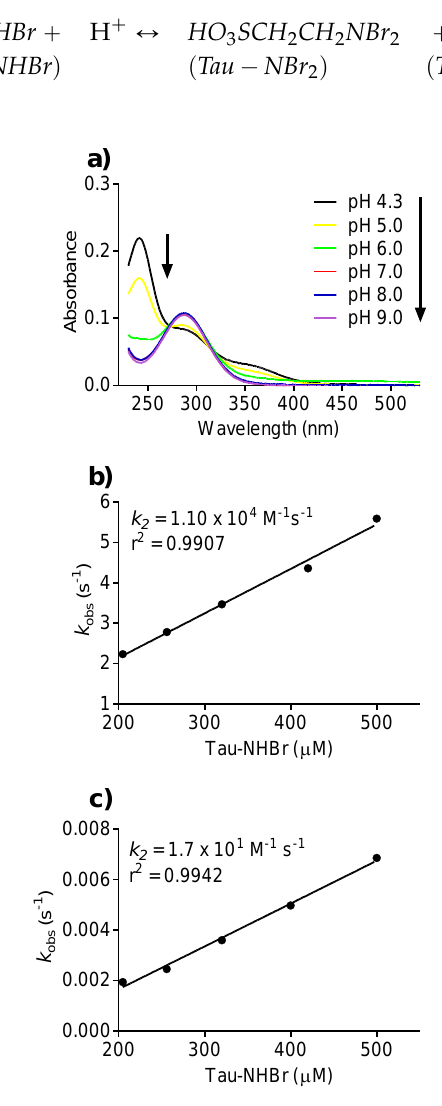
Figure 8. pH effect on Tau-NHBr reactivity. ( a ) Tau-NHBr (5 mM) was prepared in water using a 100-fold excess of taurine. The solution was diluted to 0.25 mM of NaH 2 PO 4 /Na 2 HPO 4 (50 mM) solutions combined to reach the indicated pH; ( b,c ) Reactivity of Tau-NHBr with dansylglycine at pH 5.0 and 9.0. 2.8. Reactivity of Tau-NHBr with Hydrogen Peroxide and Formation of Singlet Oxygen